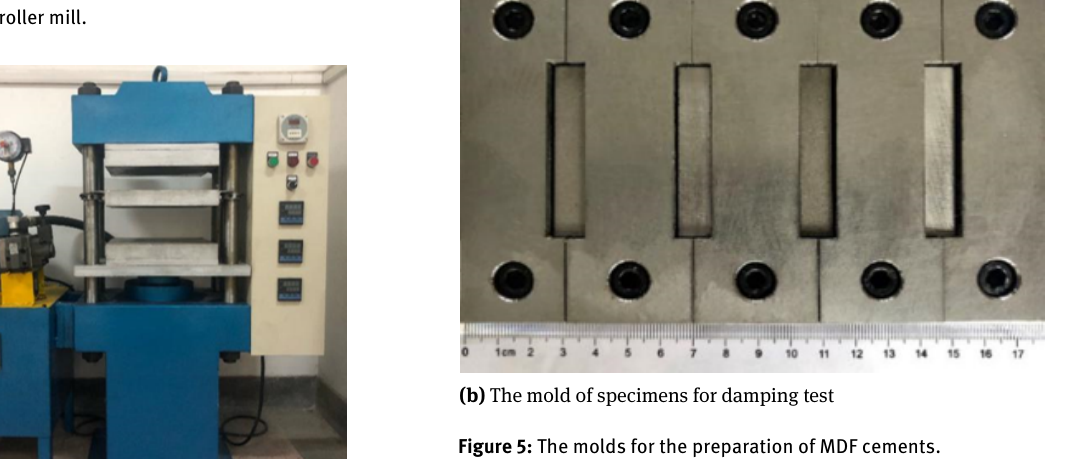
Figure 5: The molds for the preparation of MDF